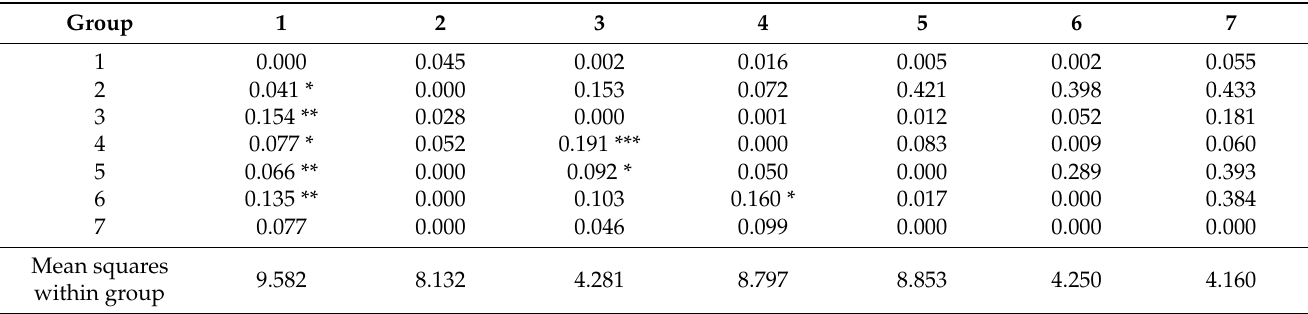
Table 4. Values of differentiation F ST (below diagonal) and probability based on non-parametric per- mutational testing procedures with 999 permutations (above diagonal) between groups of genotypes.